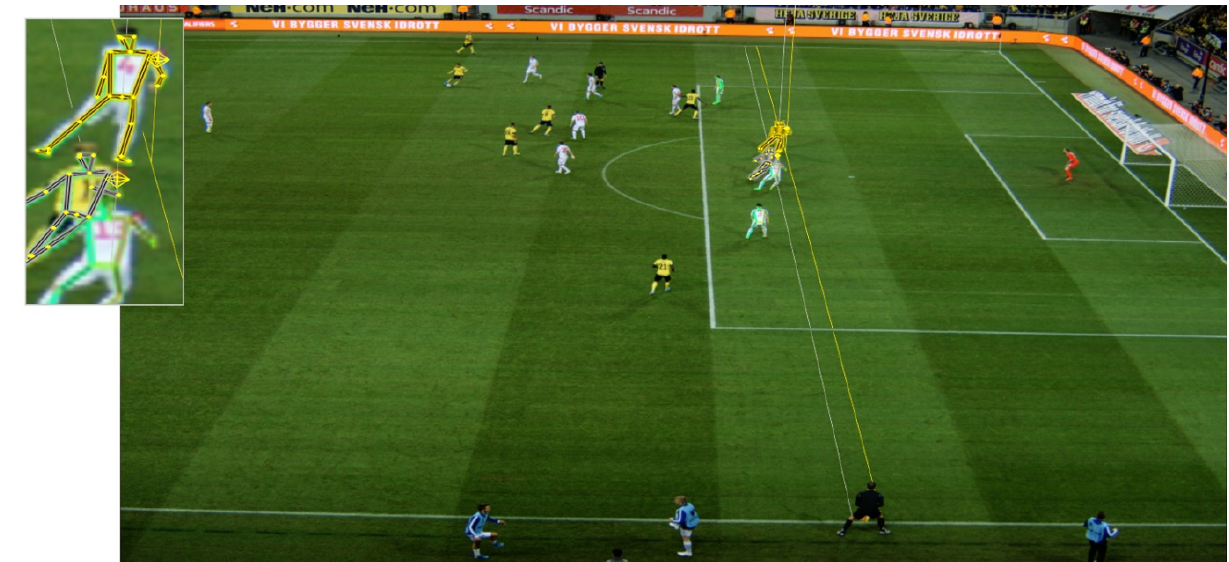
Figure 17. TRACAB Gen5 Technology for player tracking